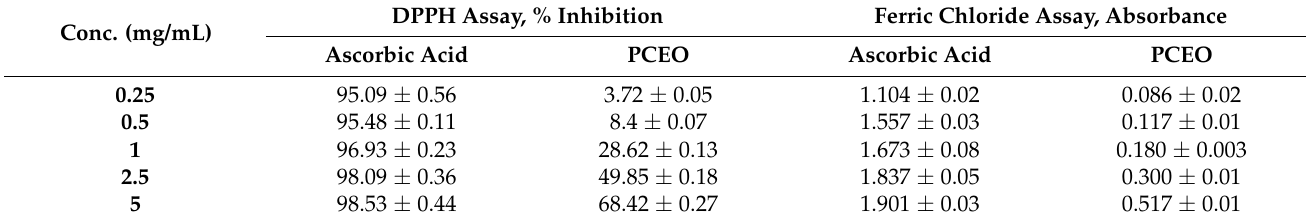
Antioxidant activity of P. crispum leaves essential oil (PCEO), using DPPH and FeCl 3